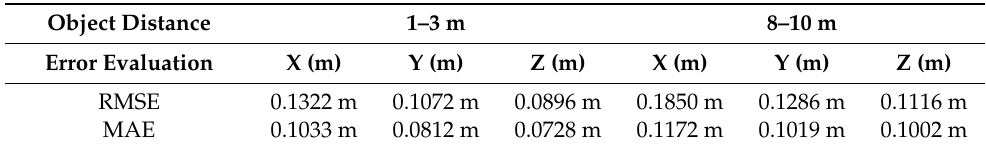
Table 6. Calculated RSME and MAE of the dynamic object position estimation with object distances being different.